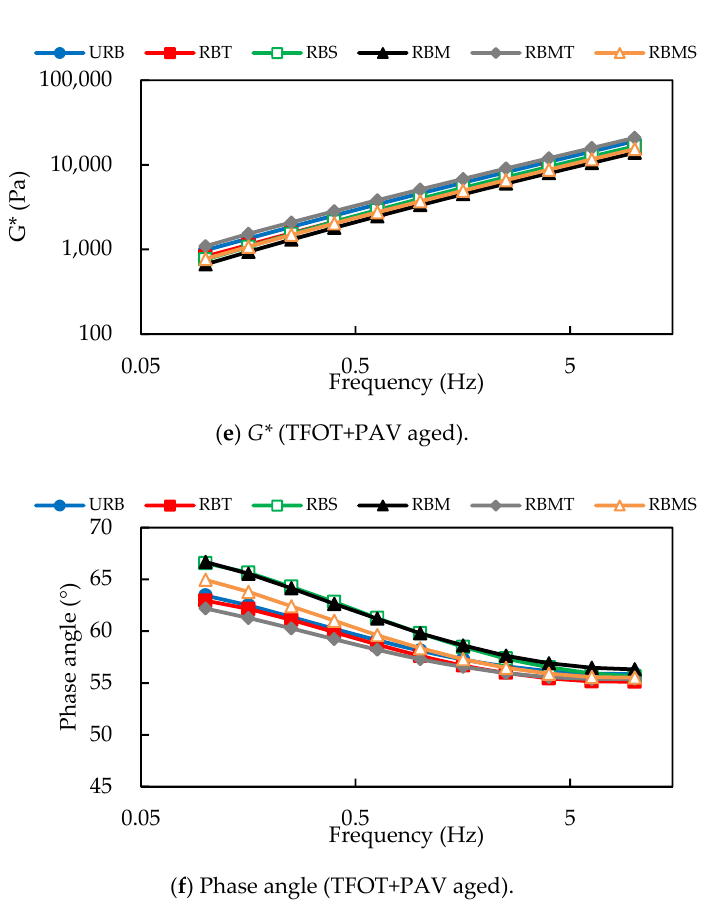
Figure 11. Effect of modification methods on the complex modulus and phase angles of rubberized bitumen depends on frequency sweep test.